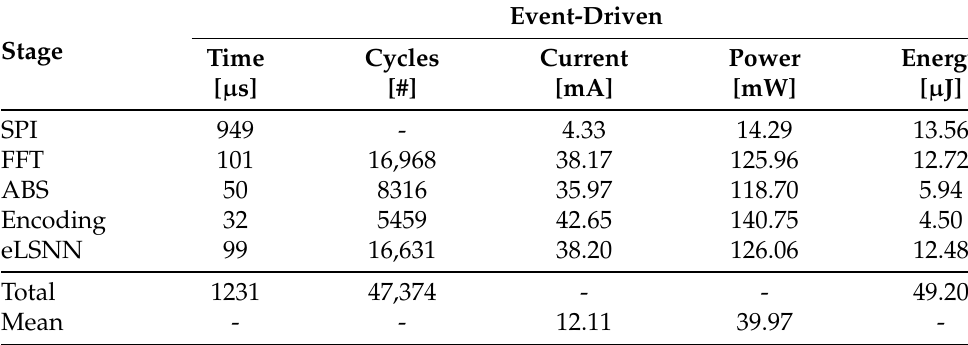
Table 4. Power report of the SHM application featuring the best eLSNNs tested. The SPI master transfers data with a serial clock of 8 MHz. The SPI stage includes: (i) The SPI data transfer, (ii) the time required by the system-on-chip to reconfigure the clock to 168 MHz when it wakes-up from SLEEP mode and (iii) the conversion of sensor data from raw integers to